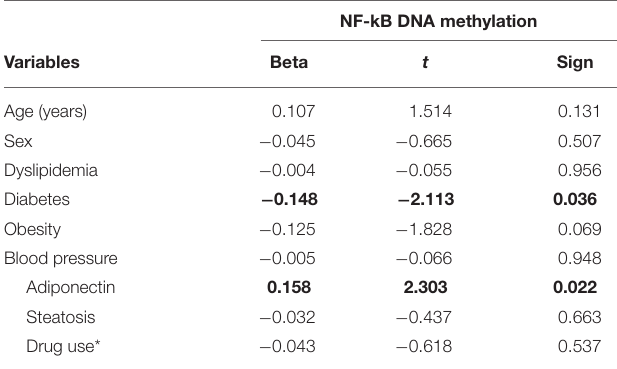
TABLE 3 | Linear regression analysis with NF-kB-DNA Methylation as the dependent